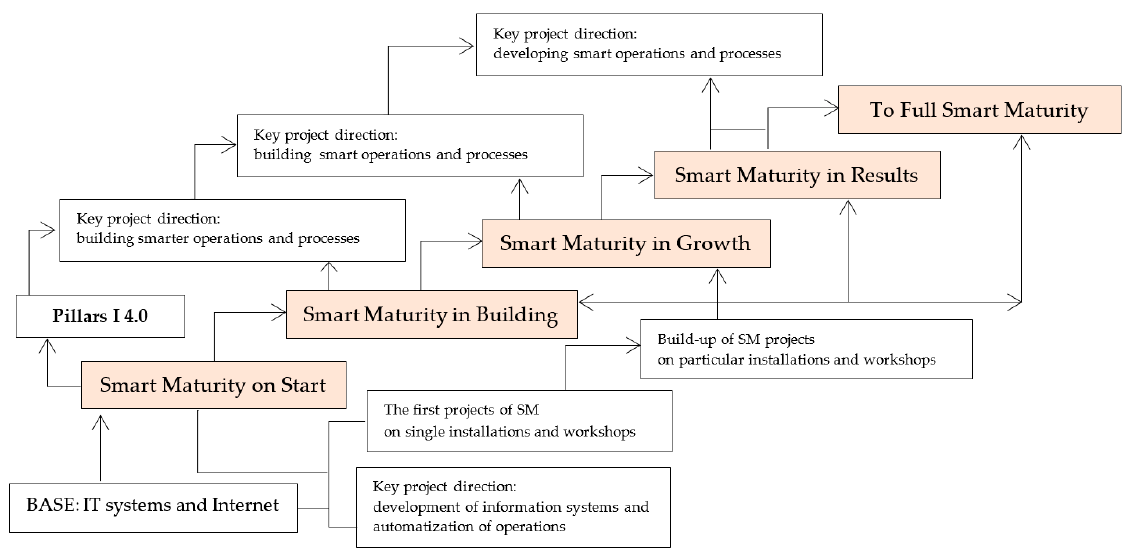
Figure 6. Levels of maturity model based on own pilot research for the segment of Polish steel industry. Own elaboration.